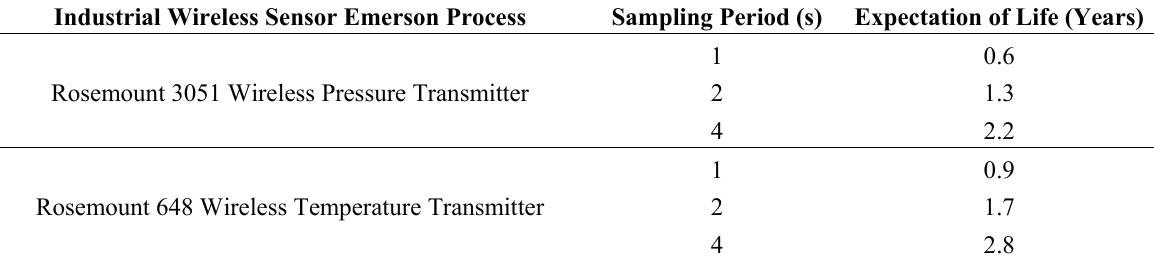
Table 5. Estimation of battery lifetime of industrial wireless sensors for different sampling periods